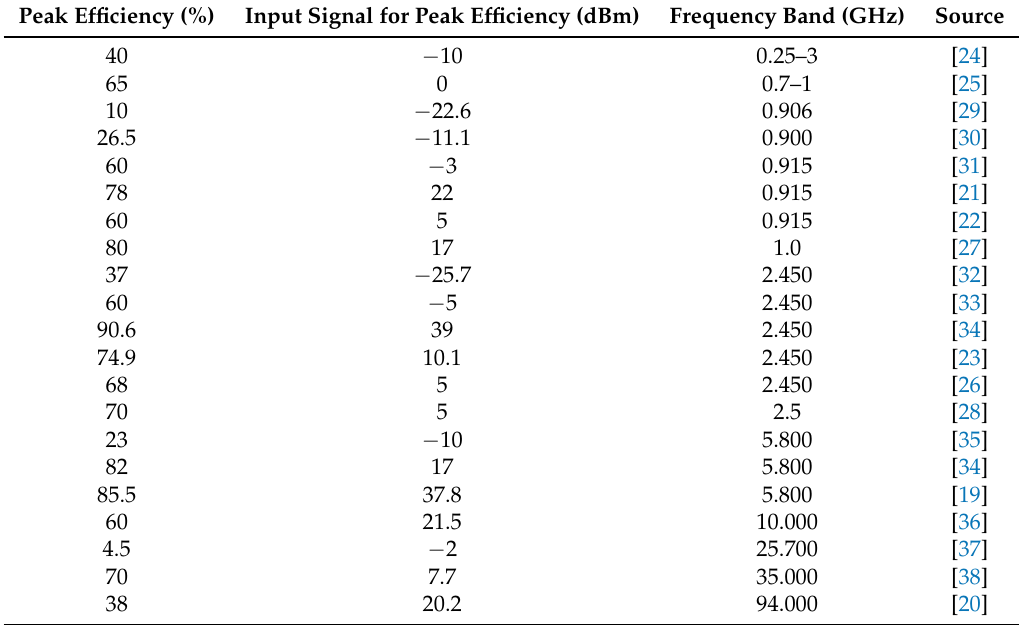
Table 1. Radio frequency to direct current conversion efficiency of selected wireless power transfer solutions (based on Refs.